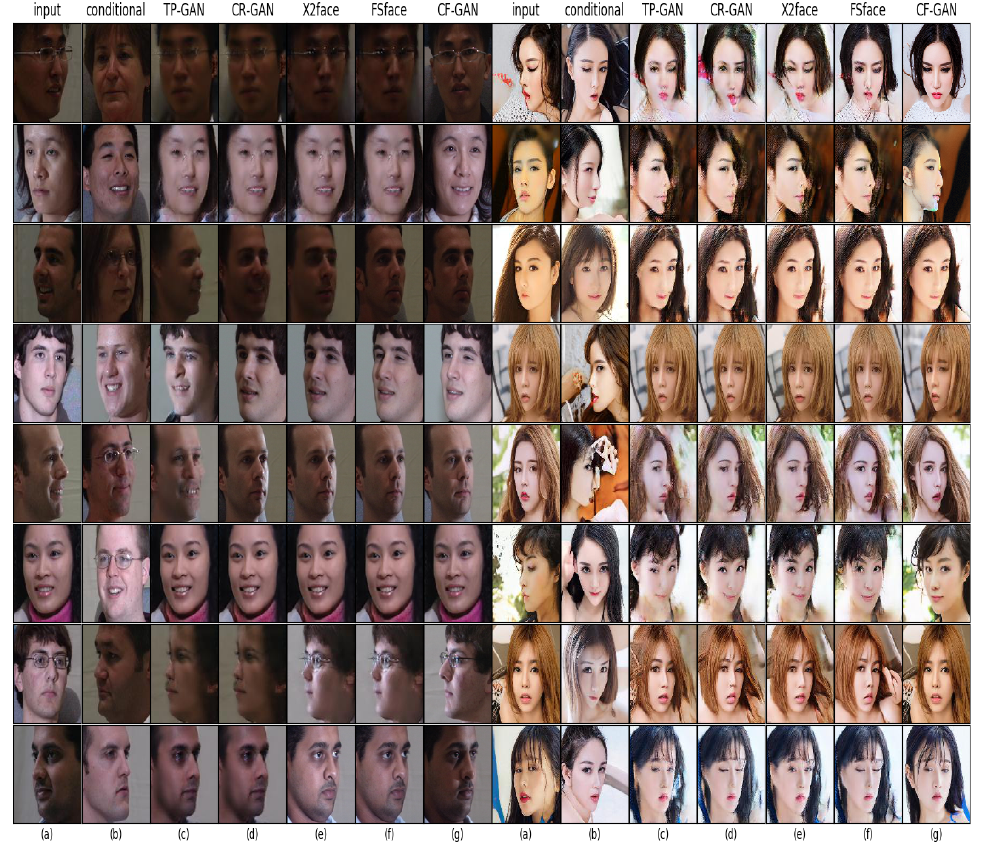
Figure 4. Experimental comparison results from two datasets under source face and conditional face have larger differences in shape and size. ( a ) Source faces. ( b ) Conditional faces. ( c ) Transfer results by TP-GAN. ( d ) Transfer results by CR-GAN. ( e ) Transfer results by X2face. ( f ) Transfer results by FSface. ( g ) Transfer results by